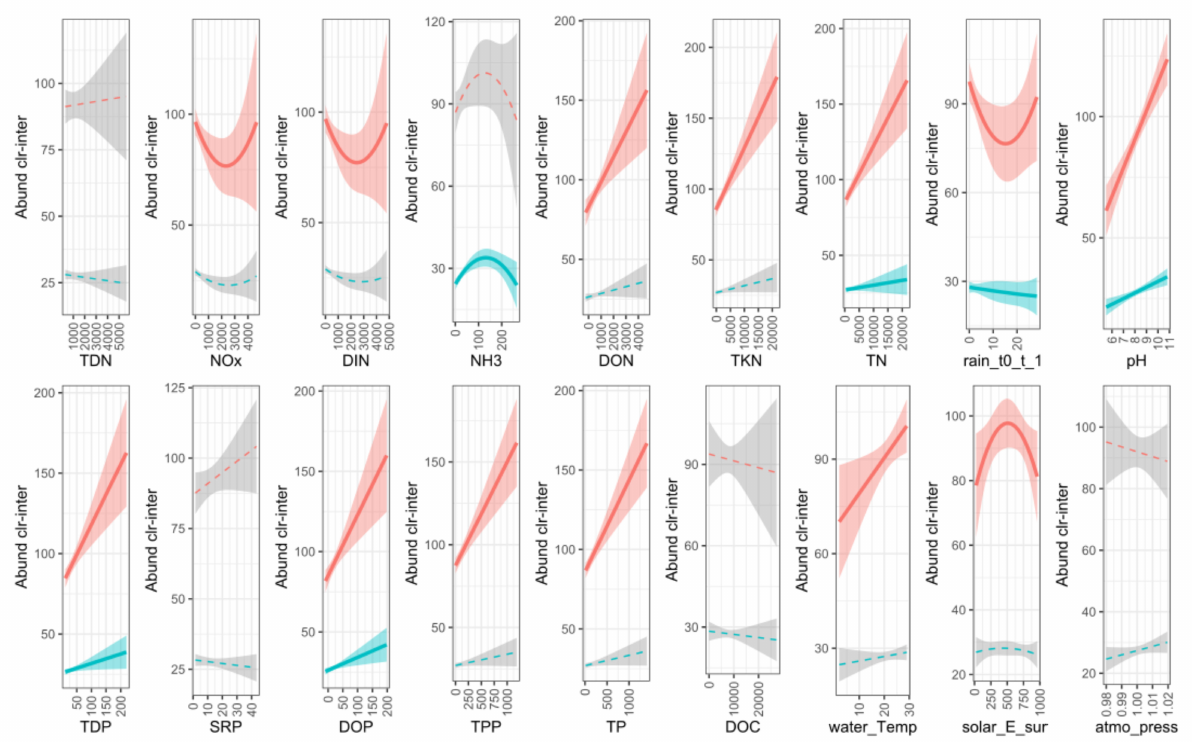
Figure 11. Response of Dolichospermum and Microcystis to environmental variables (red lines represent Dolichospermum ; blue lines represent Microcystis) . Significant relationships are shown by solid lines and coloured confidence